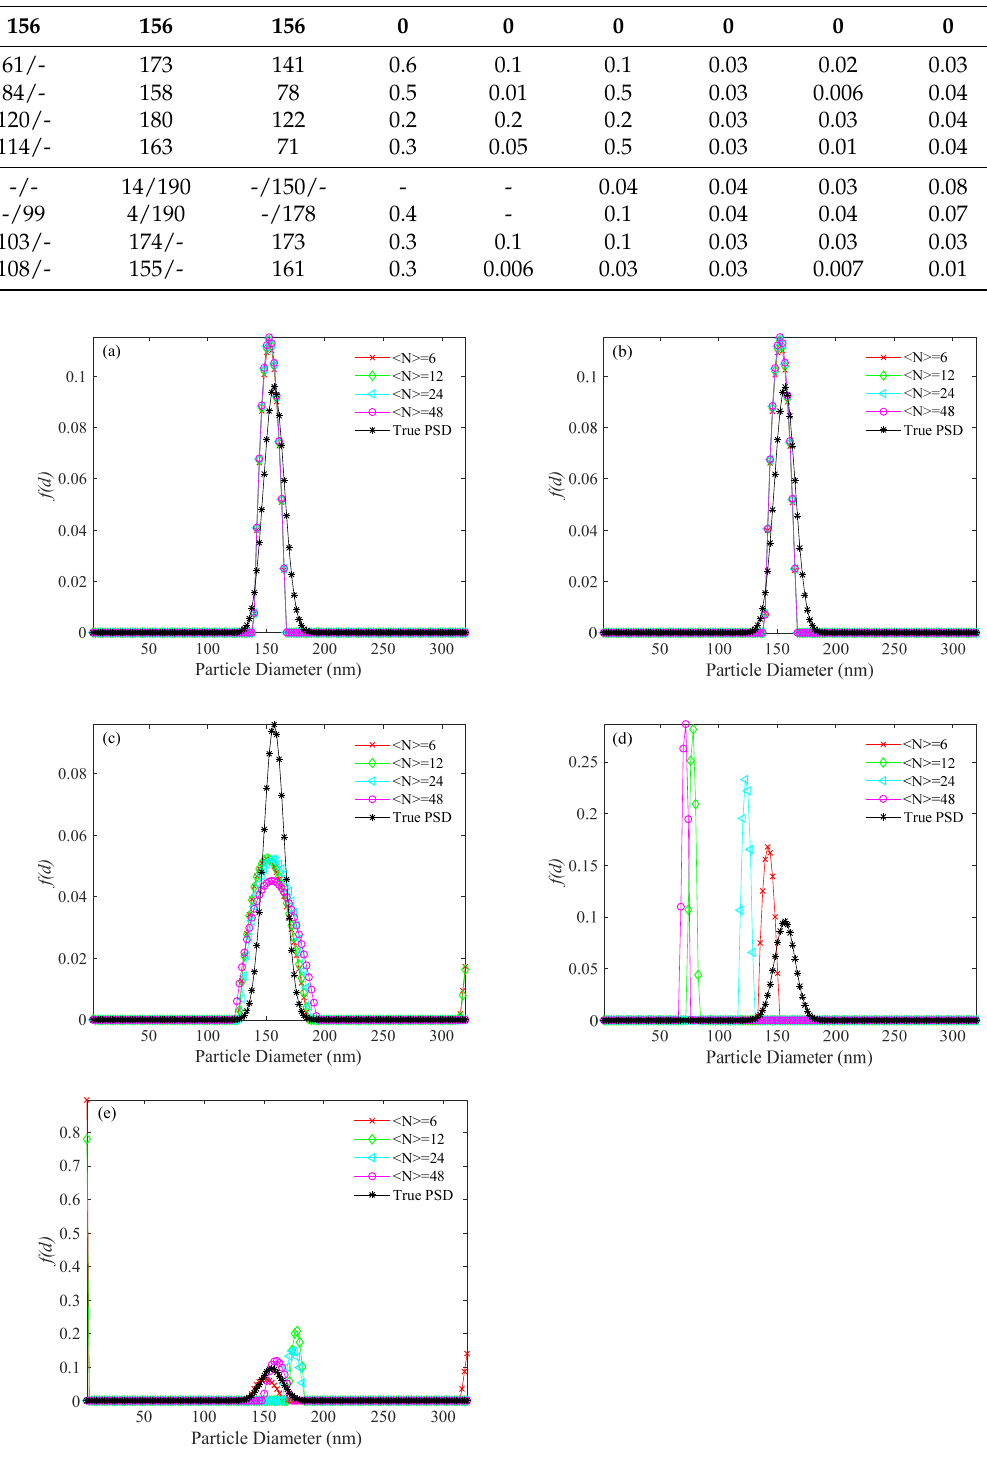
Figure 6. PSD recovered by the BR method for a 156 nm unimodal sample at number concentrations of < N > = 6, 12, 24, 48, and different levels of noise. ( a ) 0, ( b ) 10 − 4 , ( c ) 10 − 3 , ( d ) 10 − 2 , and ( e ) 10 − 1 noise levels. Table 3. Performance parameter values for the recovery of the 156 nm PSD by using three methods.